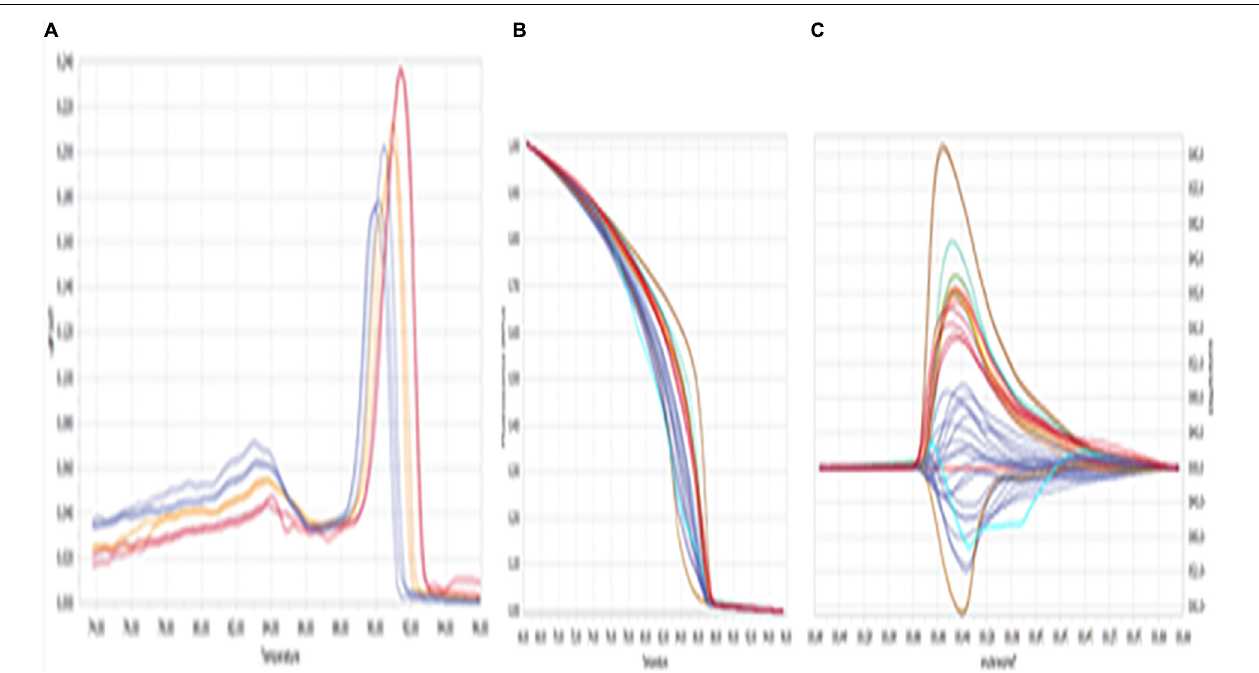
FIGURE 1 | High-resolution melting (HRM) curve profiles. (A) Dissociative/derivative HRM curves; (B) normalized melt curves; (C) differential plot curves at HSP 70. Delta Tm discrimination is 50%, and curve shape discrimination is